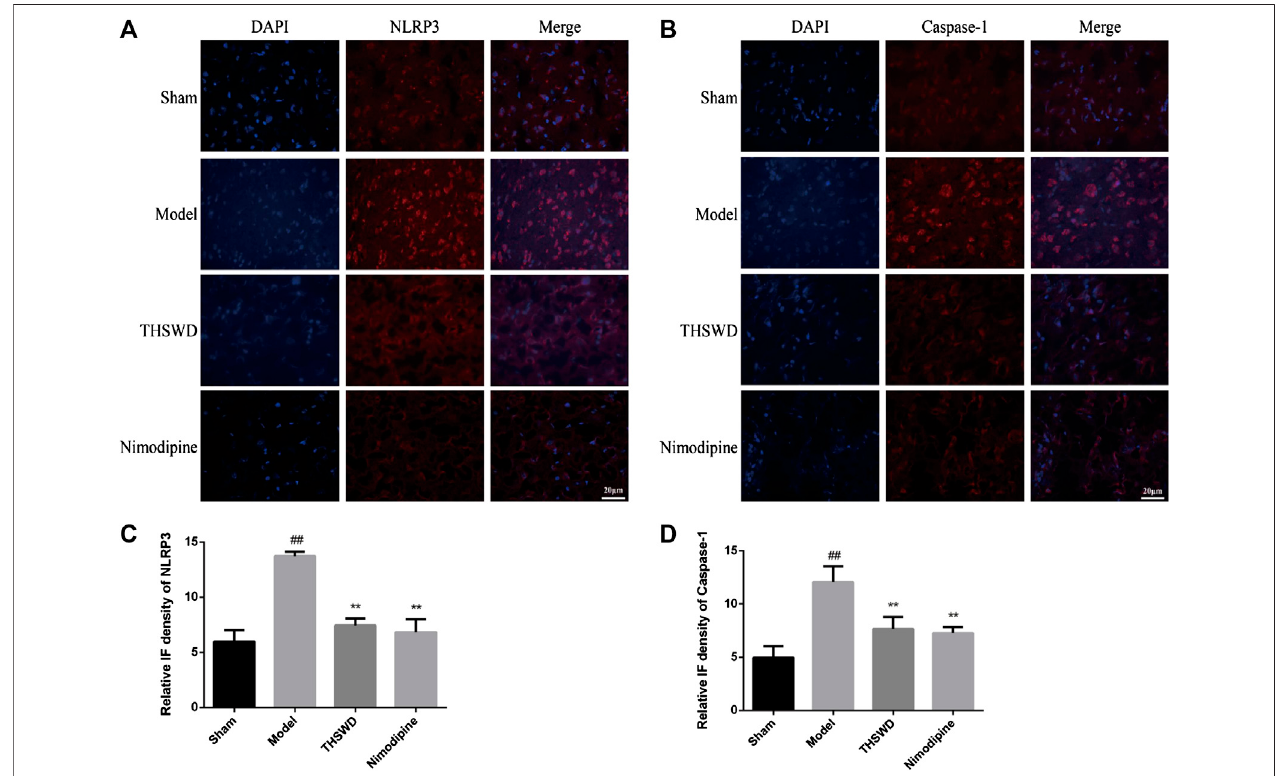
FIGURE 4 | Taohong Siwu decoction (THSWD) inhibited NLRP3 and Caspase-1 expression ( × 400). (A) NLRP3, (B) Caspase-1. The nuclei were stained blue by DAPI, and NLRP3 and Caspase-1 were red. (C,D) Fluorescence intensity analysis of NLRP3 and Caspase-1 staining ( n (cid:2) 3).